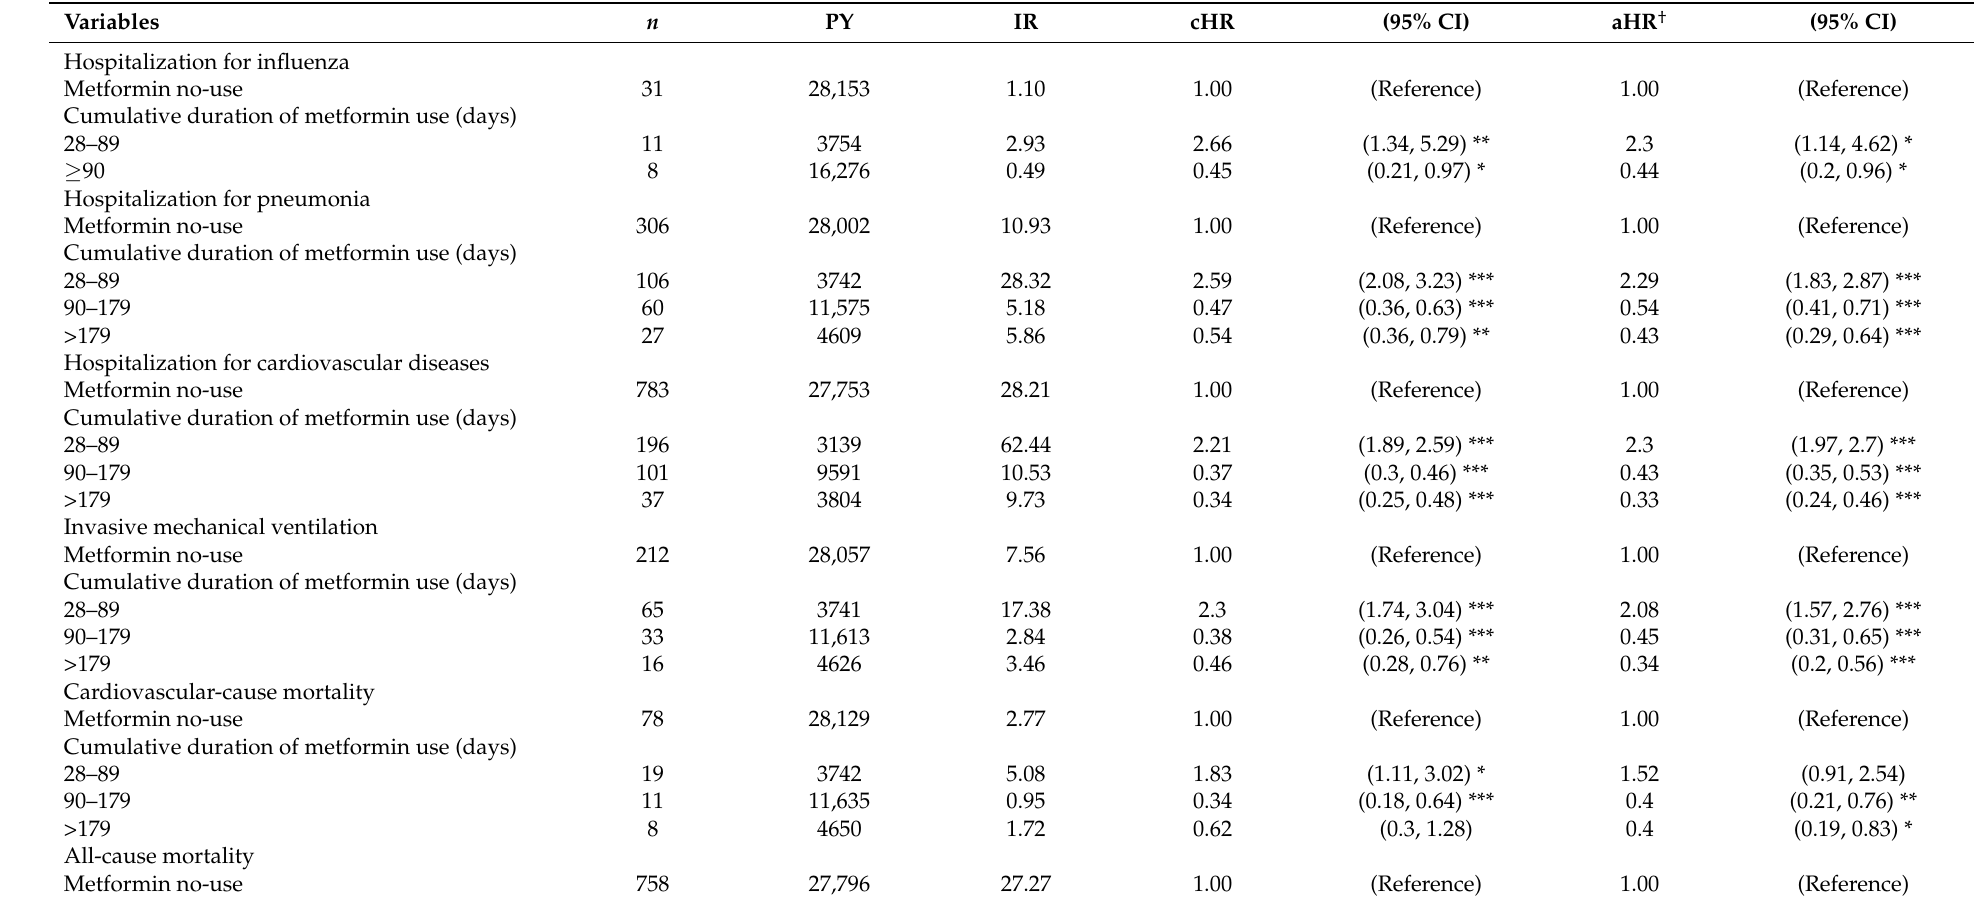
Table 4. Hazard ratio for outcome for stratification by cumulative duration of metformin